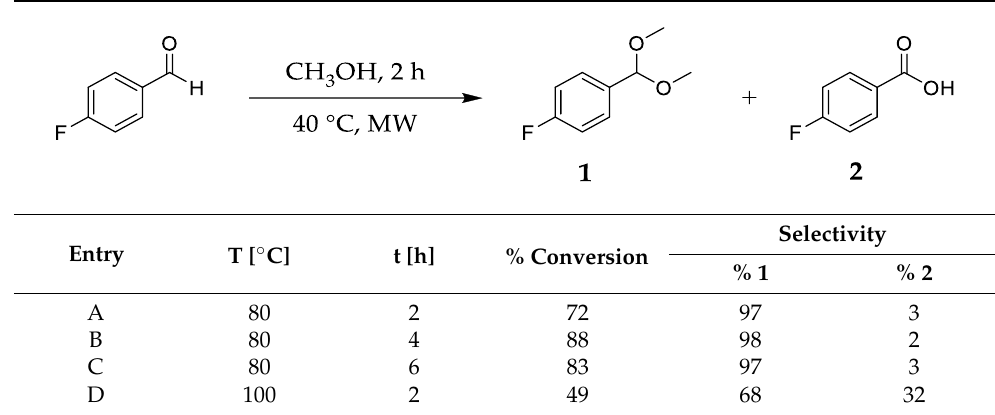
Table 11. Results of the reusability tests conducted with CNS-Cu a .